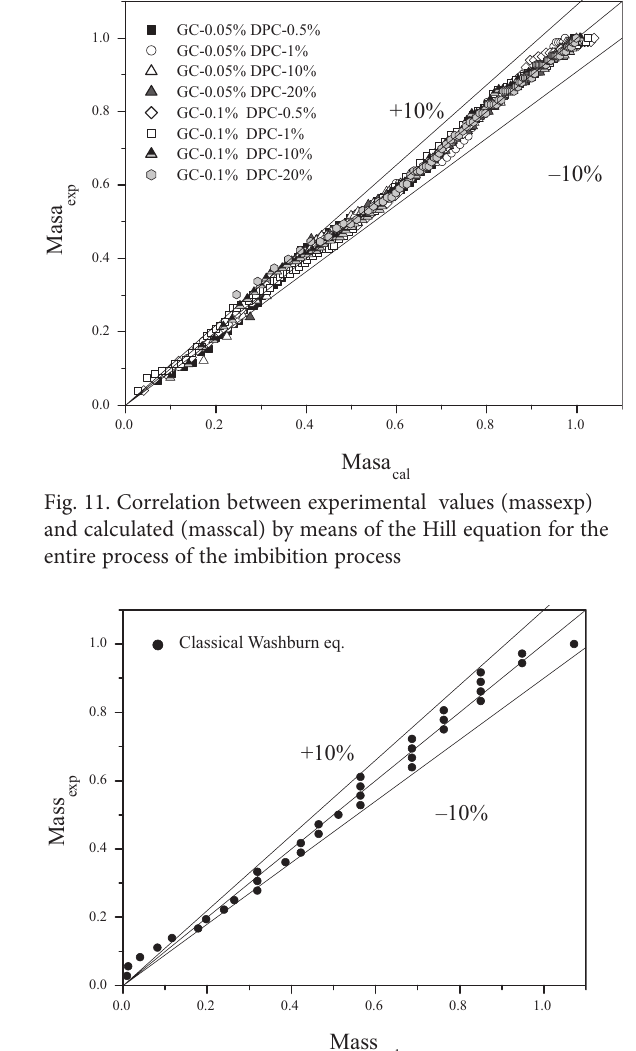
Table 7. Parameters of the equations applied to describe